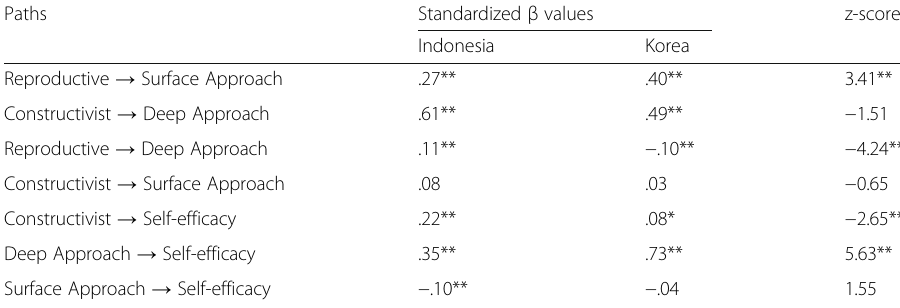
Table 4 The comparison of every path ’ s standardized β values for both countries Paths